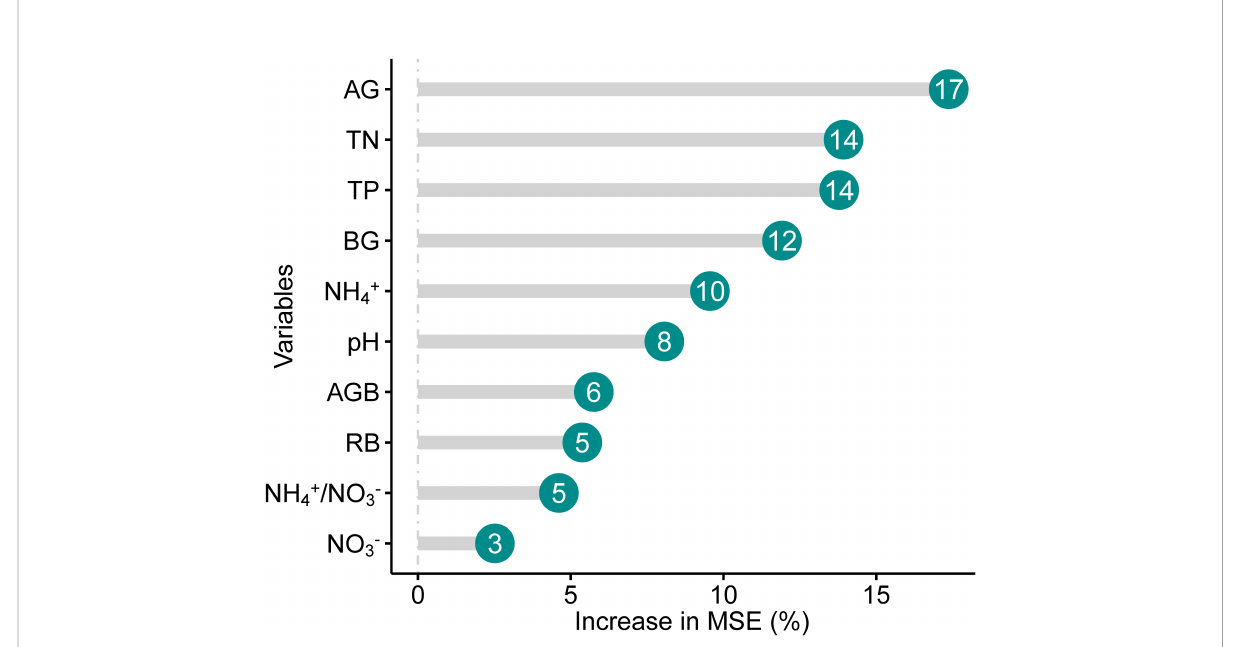
FIGURE 5 Relative contributions (Increase in MSE, %) of different factors to SOC. See Table 1 for